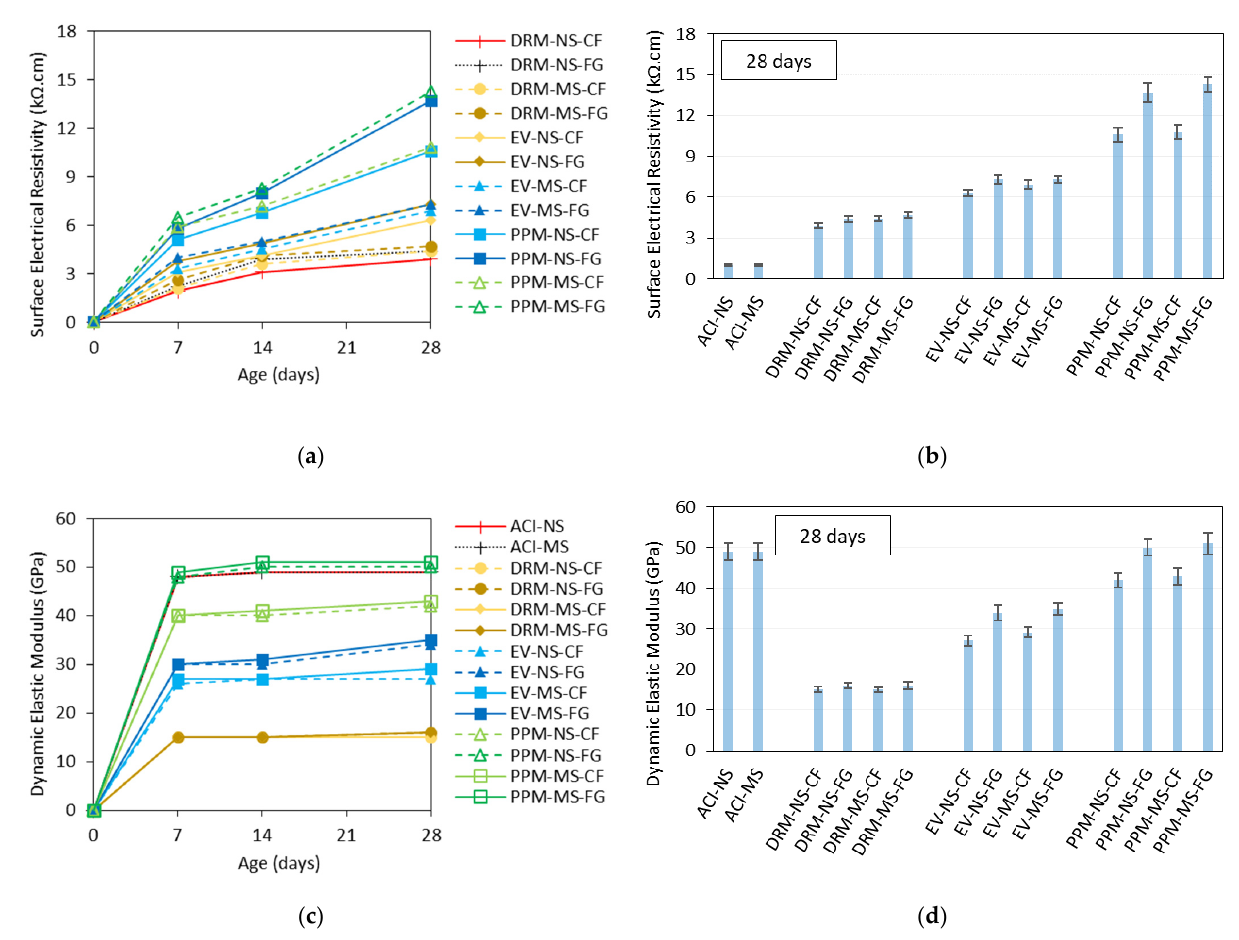
Figure 8. Non-destructive tests results: ( a ) surface electrical resistivity over time, ( b ) surface electrical resistivity at 28 with error bars, ( c ) dynamic elastic modulus over time, and ( d ) dynamic elastic modulus at 28 with error bars.